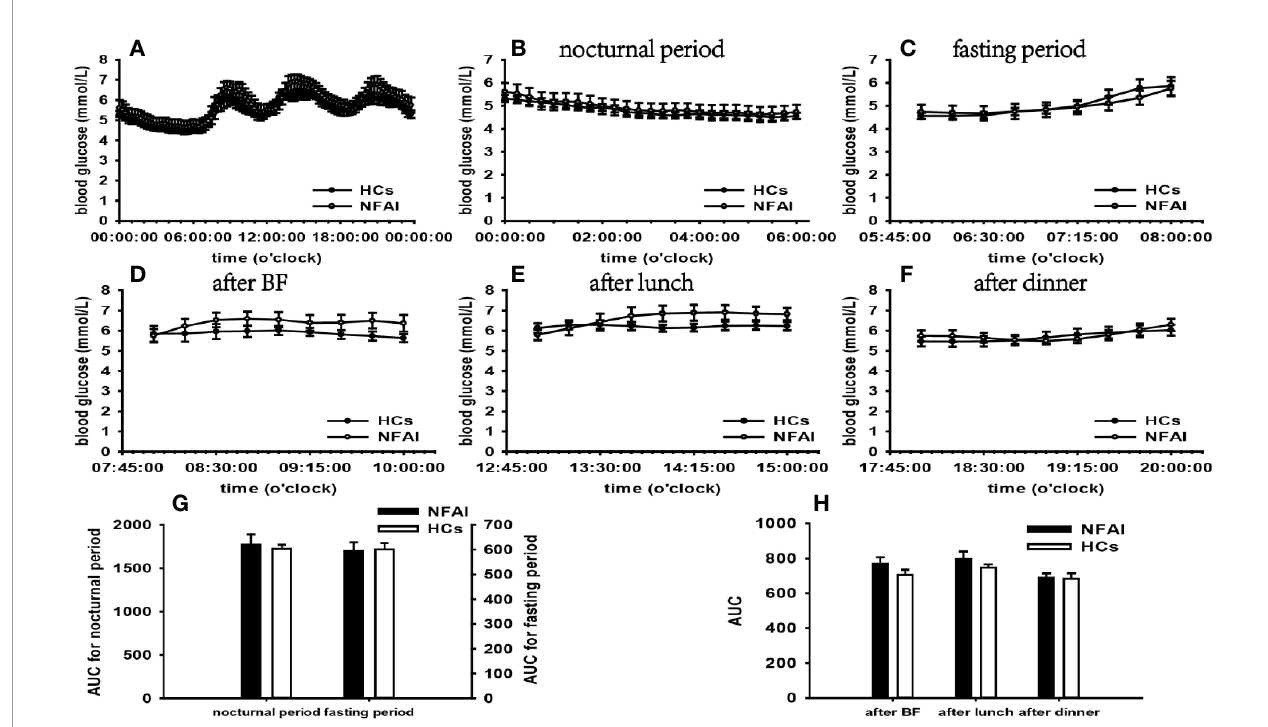
FIGURE 5 | Comparison of the mean blood glucose level and AUC between the NFAI group and HCs. Mean blood glucose level: (A) at each time point during the day; (B) at nocturnal period; (C) at fasting period; (D) after BF; (E) after lunch; (F) after dinner. AUC: (G) at nocturnal and fasting periods; (H) at postprandial periods. The data showed as mean ± SEM. AUC, area under the curve; NFAI, nonfunctional adrenal incidentaloma; HCs, healthy controls; BF, breakfast; SEM, standard error of